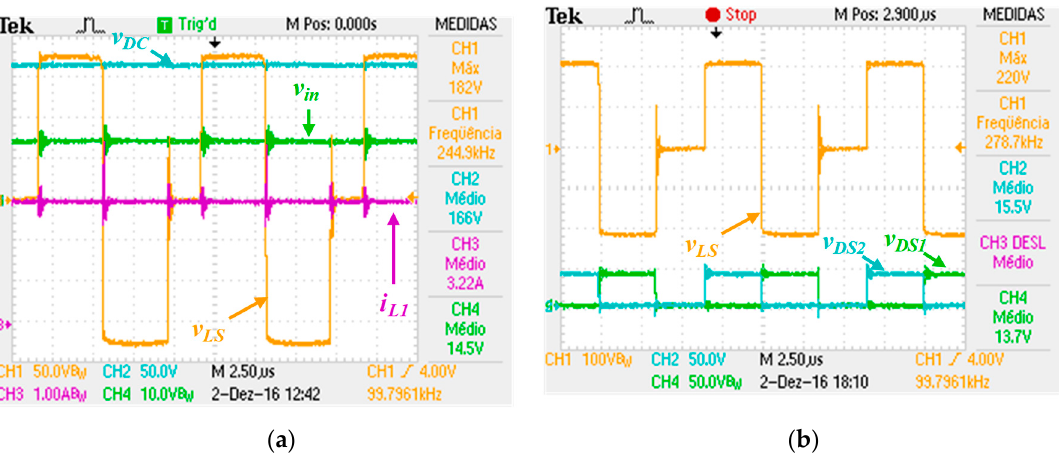
Figure 16. Experimental results of the DC–DC power converter: ( a ) v DC , v in , v LS and inductor current ( i L 1 ) with the MPPT algorithm enabled; ( b ) v LS and the drain-source voltage ( v DS 1 and v DS 2 ) in each MOSFET with the MPPT algorithm enabled.